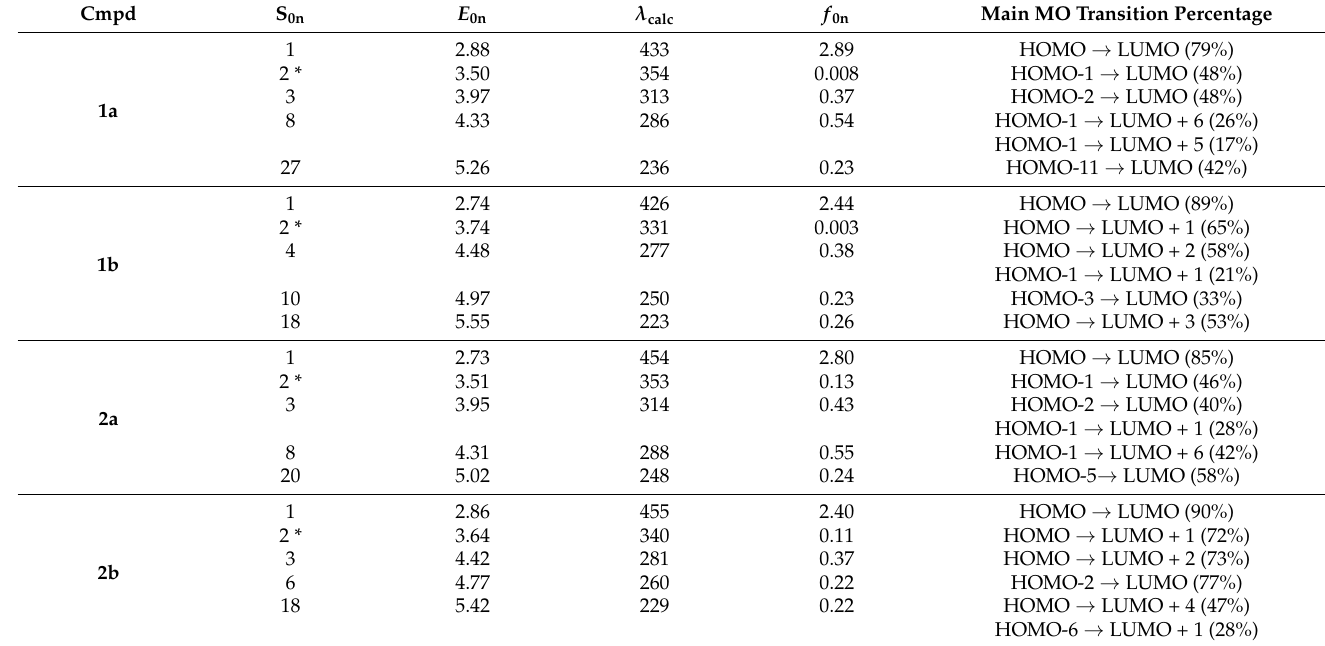
Table 3. CAM-B3LYP calculations for the four lowest-energy excitations of the most stable form ( a ) in toluene (PCM). E 0n is the transition energy (in eV), λ calc is the wavelength (in nm) and f 0n is the oscillator strength of the absorption